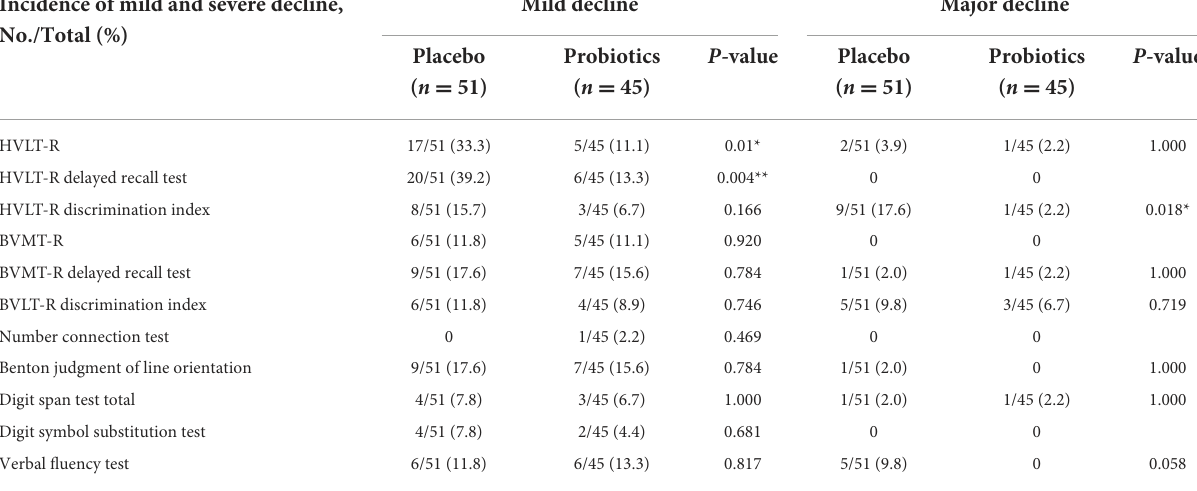
TABLE 5 Incidence of mild and severe decline in each neuropsychological test in different groups. Incidence of mild and severe decline,